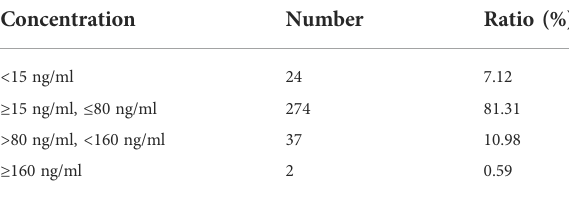
TABLE 3 Distribution of blood drug concentration in all